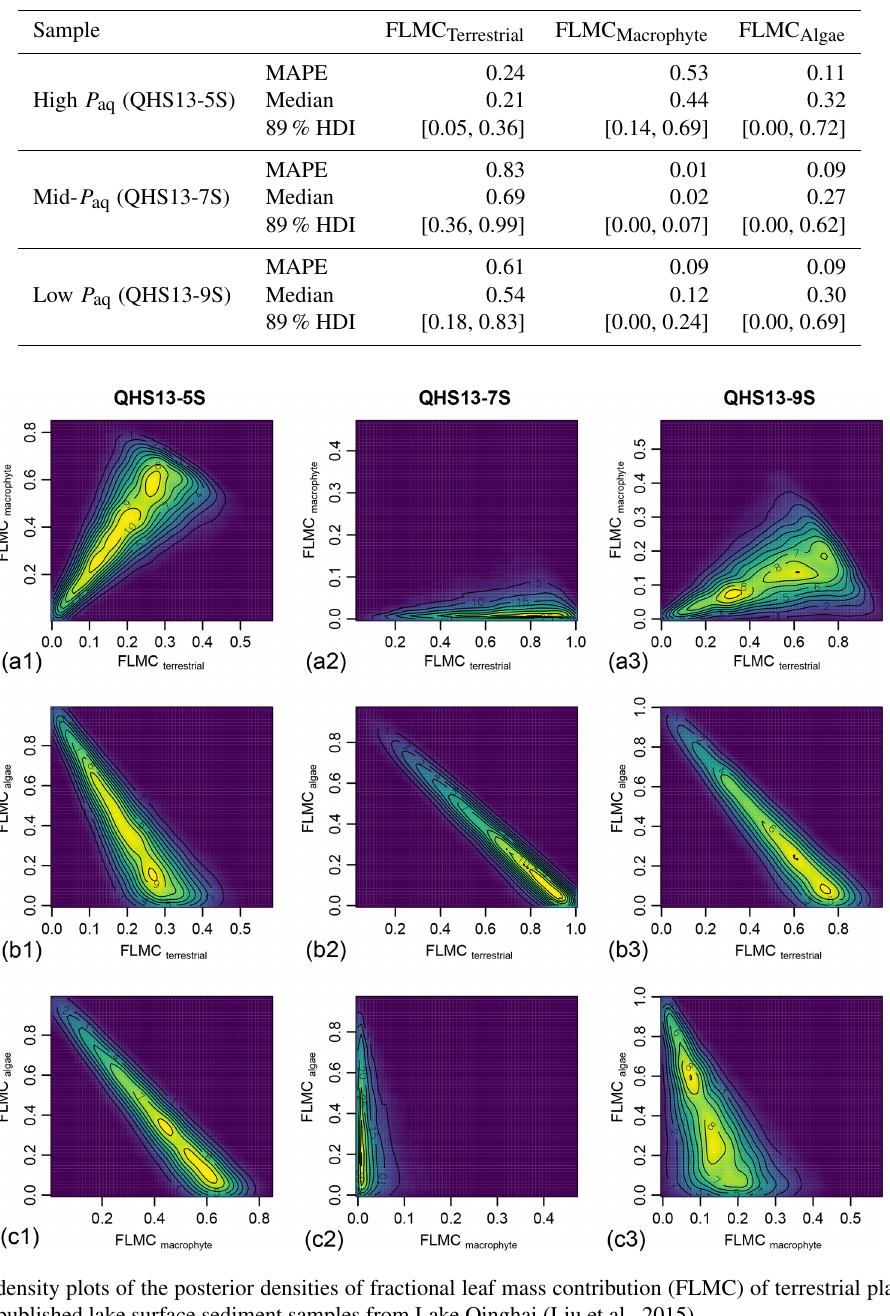
resented by multiple bivariate density peaks (as indicated by the contour lines and color gradient, Fig.